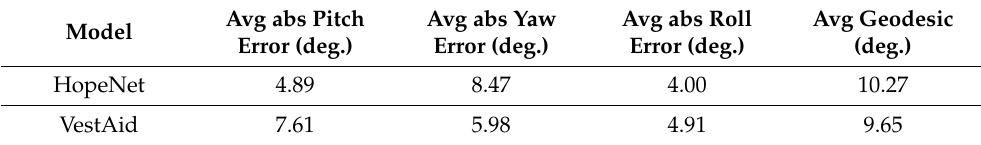
Table 4. VestAid and HopeNet head-angle estimation accuracy on a subset of Biwi dataset.